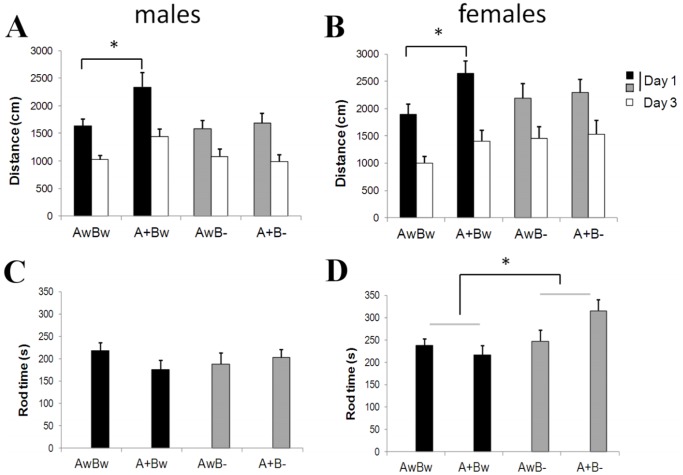

Bdnf gene deficiency normalizes the hyperactivity/hyperexploration of APdE9 mice.Distance traversed (cm) in a novel test cage during 10 min on day 1 and day 3 (habituation) in males (A) and in females (B). * Significant APdE9 gene effect among Bdnf wild-type mice, (p<0.05, ANOVA-rm). Bdnf gene deficiency does not impair motor coordination and balance despite obesity. Time on the accelerating rotarod in males (C) and in females (D). * Significant main effect of the Bdnf gene deficiency (p = 0.02, ANOVA). Abbreviations for genotypes: AwBw = wt x wt; AwB− = wt x Bdnf+/−; A+Bw = APdE9 x wt; A+B− = APdE9 x Bdnf+/−.